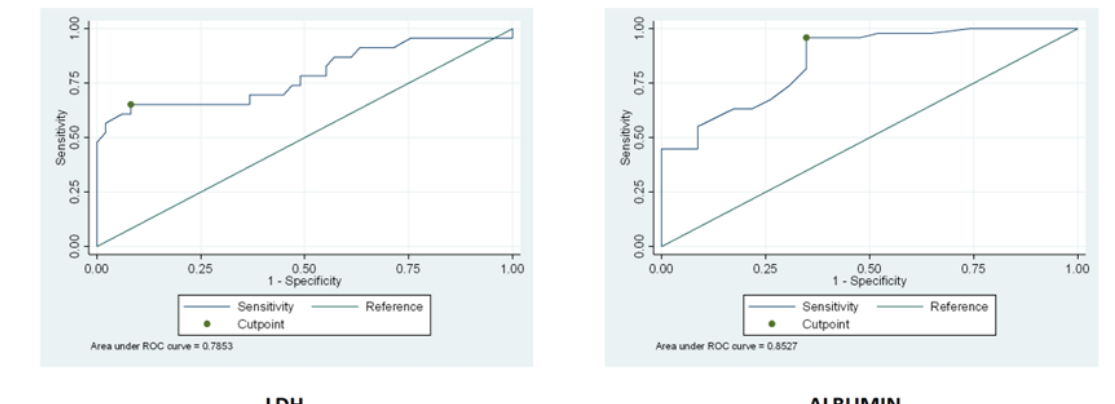
Figure 3. The figure below represents the ROC curves of LDH and ALBUMIN. A cut-off point was calculated for both these biomarkers in order to predict refractoriness .